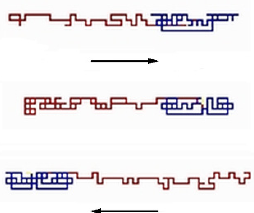
Figure 1. The visualization of the conformation of the macromolecule in the nanochannel. The self-attracting part of macromolecule P1 is marked in blue, whereas the athermal part P2 in red ( N = 200, ε PP / k B T = − 1 and 0 for P1 and P2, respectively, D = 4 b ). Arrows indicate the direction of movement of the whole chain.